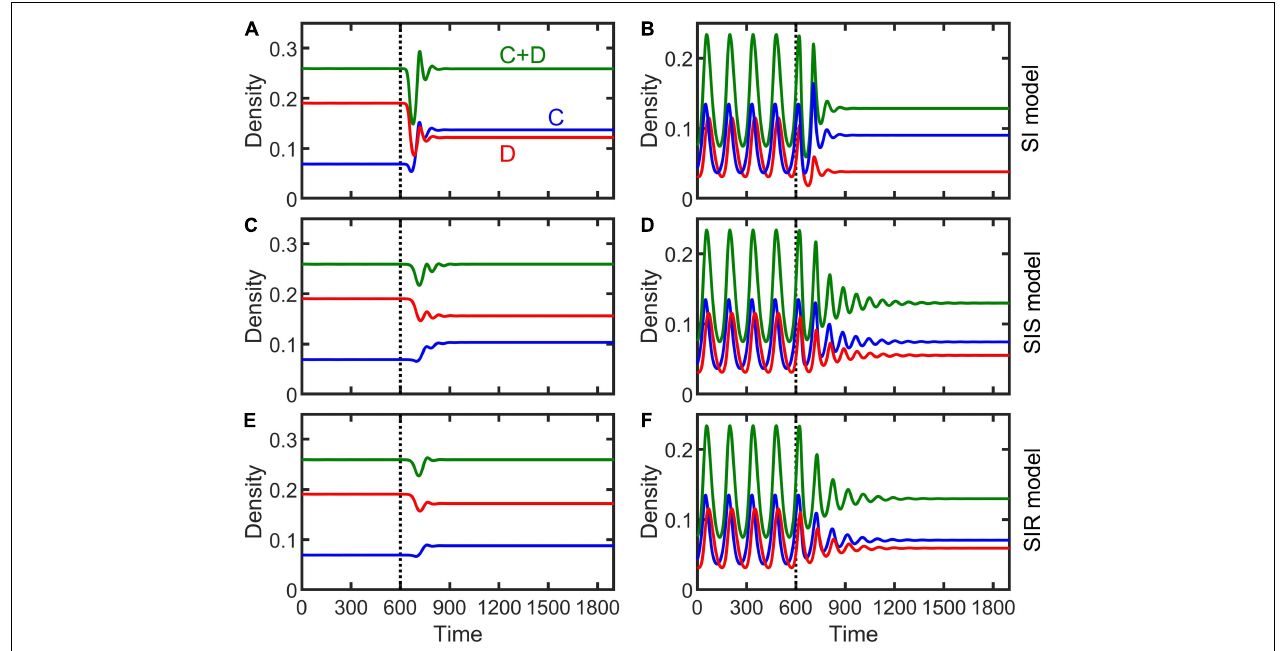
FIGURE 3 | Effect of infectious diseases on the evolution of cooperation in stable (left column) or periodically fluctuating (right column) populations in the SI (A,B) , SIS (C,D) , and SIR (E,F) models. Vertical dashed lines indicate the time when infectious disease occurs in the population. Parameters are β = 0 . 8, κ = 0 . 8, ξ = 0 . 1, γ = 0 . 1, δ = 0 . 12 for left column and δ = 0 . 16 for right column, and the other parameters the same as Figures 1A,C